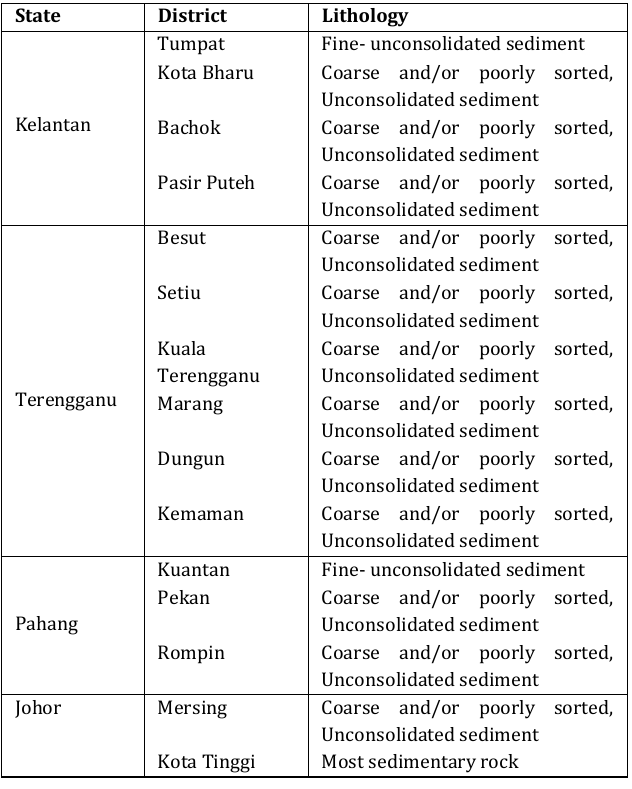
Table 7: Rock type along the East Coast of Peninsular